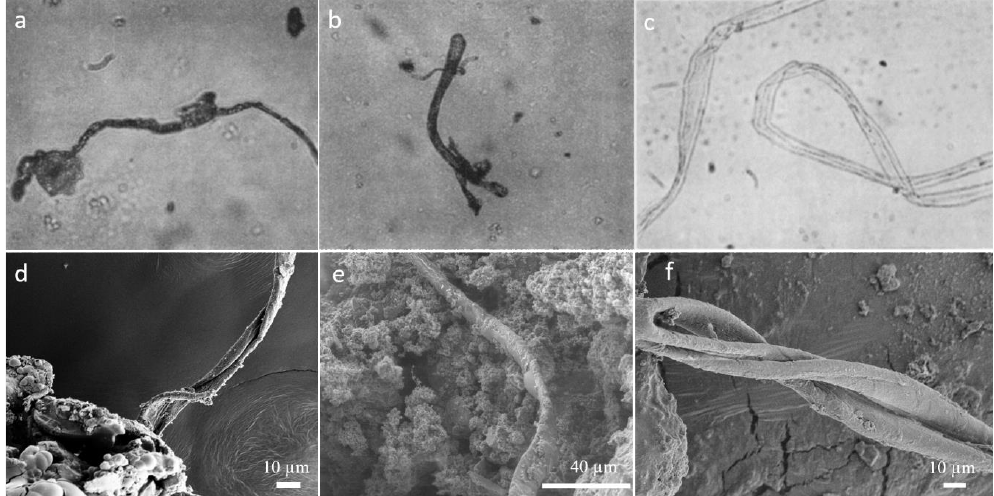
Figure 5. Photomicrographs of filamentous structures observed of size range ~ 20 µm in ( a ) Mighei meteorite, ( b ) Murray meteorite, ( c ) Dimmit meteorite [45] and ( d – f ) similar structures observed in SEM micrographs of shock processed residue of amino acid. Molecules 2020 , 25 , x FOR PEER REVIEW 8 of 12